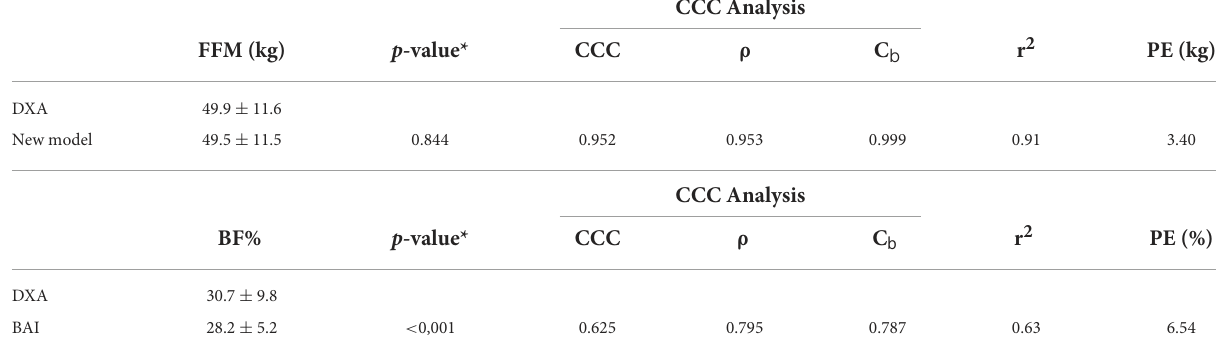
TABLE 2 Cross-validation of FFM predictive new model, and validation of BAI for